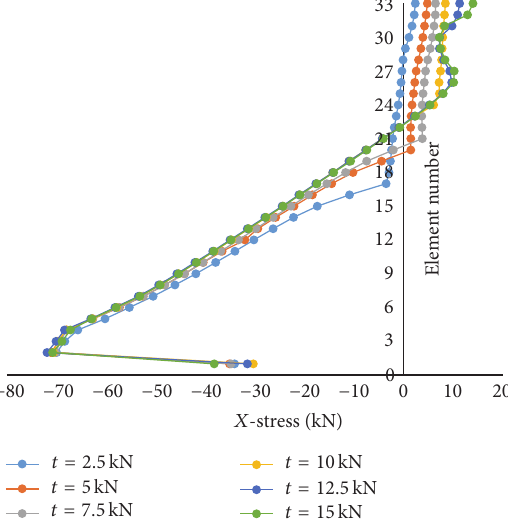
Figure 10: Distribution of earth